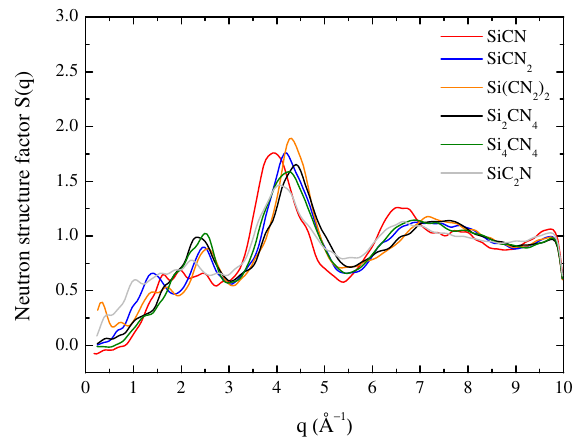
Figure 5. Neutron structure factor of the a-SiC x N y